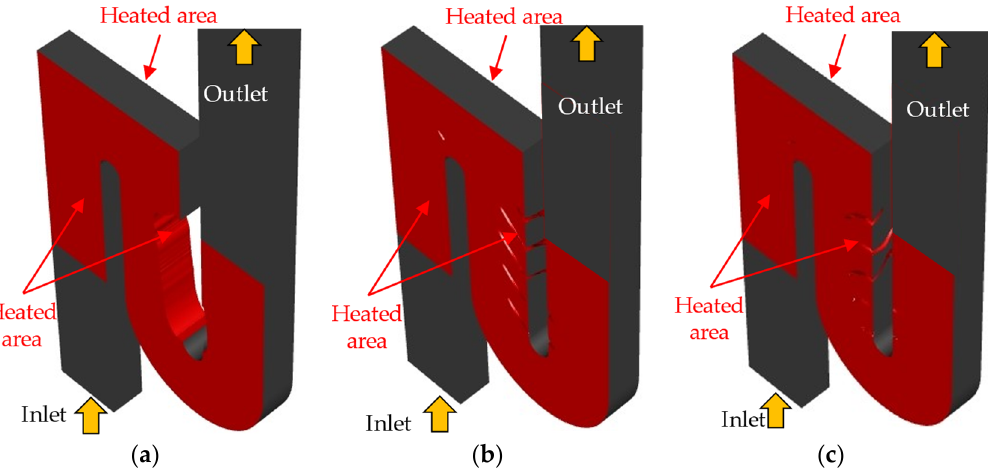
Figure 9. Models for comparison: ( a ) optimized model extracted with density filtering of 0.5 (TO model); ( b ) optimized model infilled with diamond ‐ sheet structure (TO model with diamond ‐ model); ( b ) optimized model infilled with diamond-sheet structure (TO model with diamond-TPMS); TPMS); ( c ) optimized model infilled with diamond ‐ sheet structure (TO model with gyroid ‐ TPMS). ( c ) optimized model infilled with diamond-sheet structure (TO model with gyroid-TPMS).